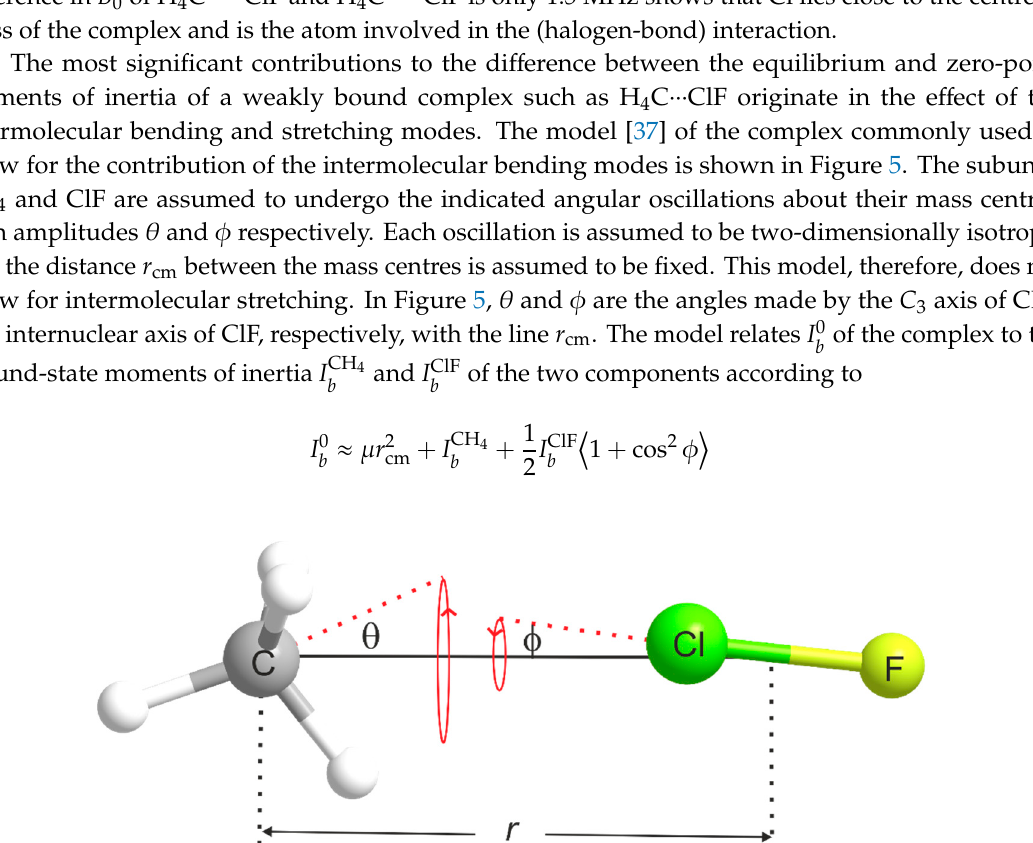
(cid:3117) (cid:3118) , and intermolecular